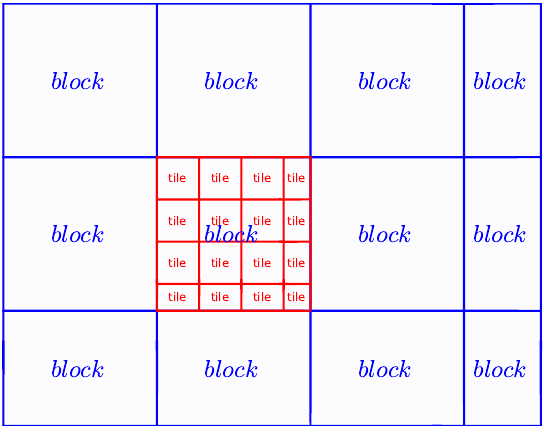
Figure 2. Blocks of an image and tiles of a